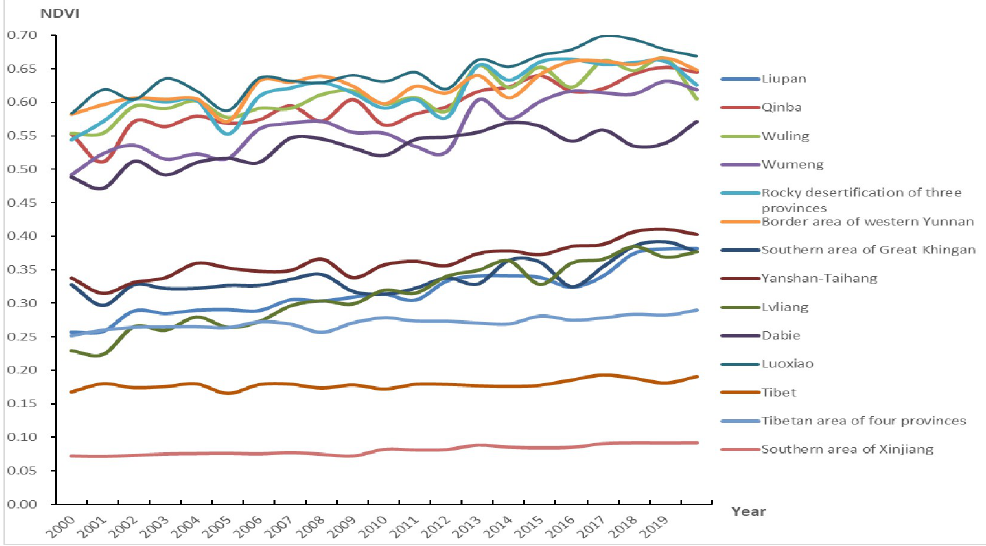
Fig 4. Average annual NDVI in the fourteen contiguous areas of dire poverty from 2000 to